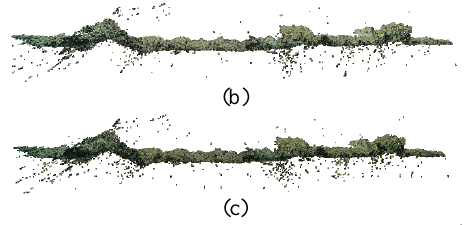
Figure 10. The unfiltered point clouds of the dataset 1. (a) the resulted point cloud using the uncorrected images , (b) the resulted point cloud using the corrected ct images and (c) the produced point cloud using the corrected orig. images